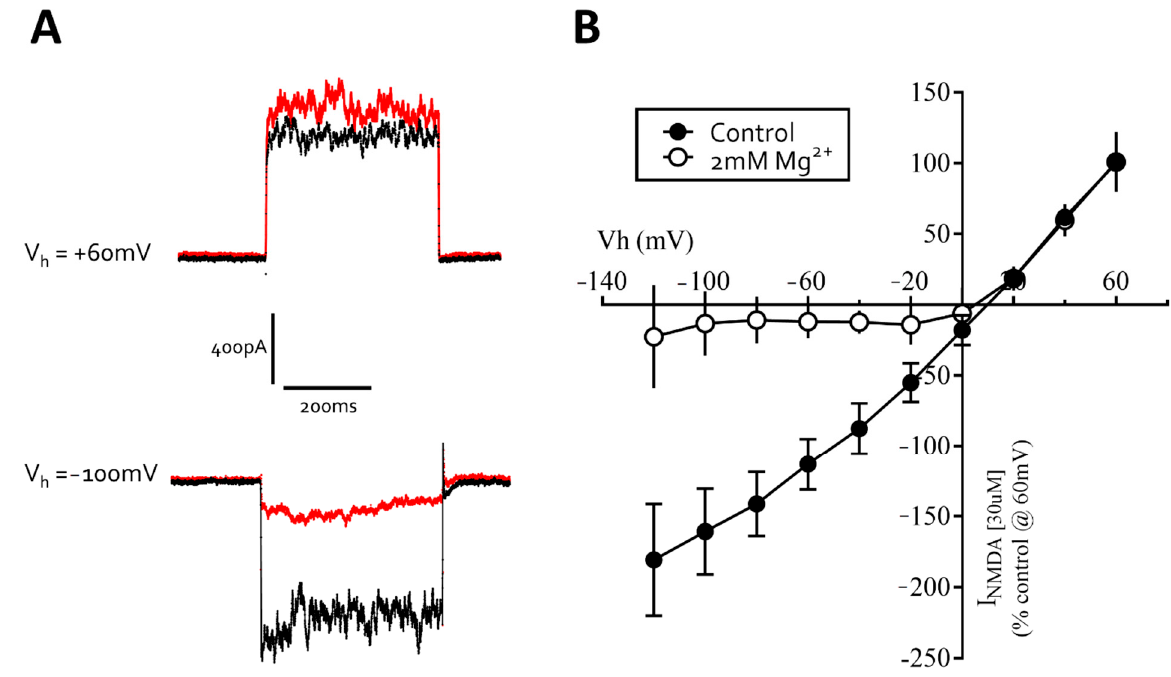
Figure 9. Mg 2+ inhibits NMDA-evoked currents recorded from iCell neurons in a highly voltage-dependent fashion. ( A ) recording of responses to short (400 ms) pulses of NMDA (30 μ M) applied to a neuron voltage-clamped at +60 and − 100 mV in the absence (black line) and presence (red line) of Mg 2+ (2 mM). ( B ) the current-voltage relationship for NMDA (30 μ M) responses in the absence ( ● ) and presence ( ○ ) of magnesium ions. Note the negative slope conductance above − 20 mV when magnesium is included in the bath solution. The x -axis shows the holding potential (Vh) and the y -axis is the NMDA current normalized to +60 mV. The graph is the mean of 4 cells.